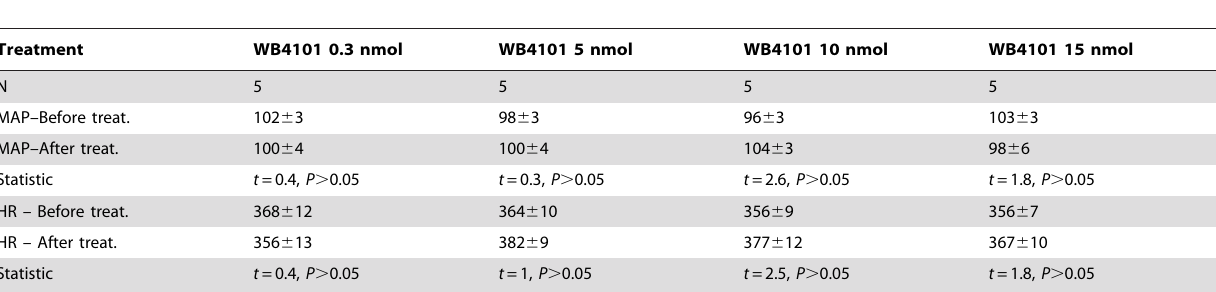
Table 1. Effect of bilateral microinjections into the IC of crescent doses (0.3, 5, 10 and 15 nmol/100 nl) of the selective a 1 - adrenoceptor antagonist WB4101 on mean arterial pressure (MAP) and heart rate (HR) baseline.